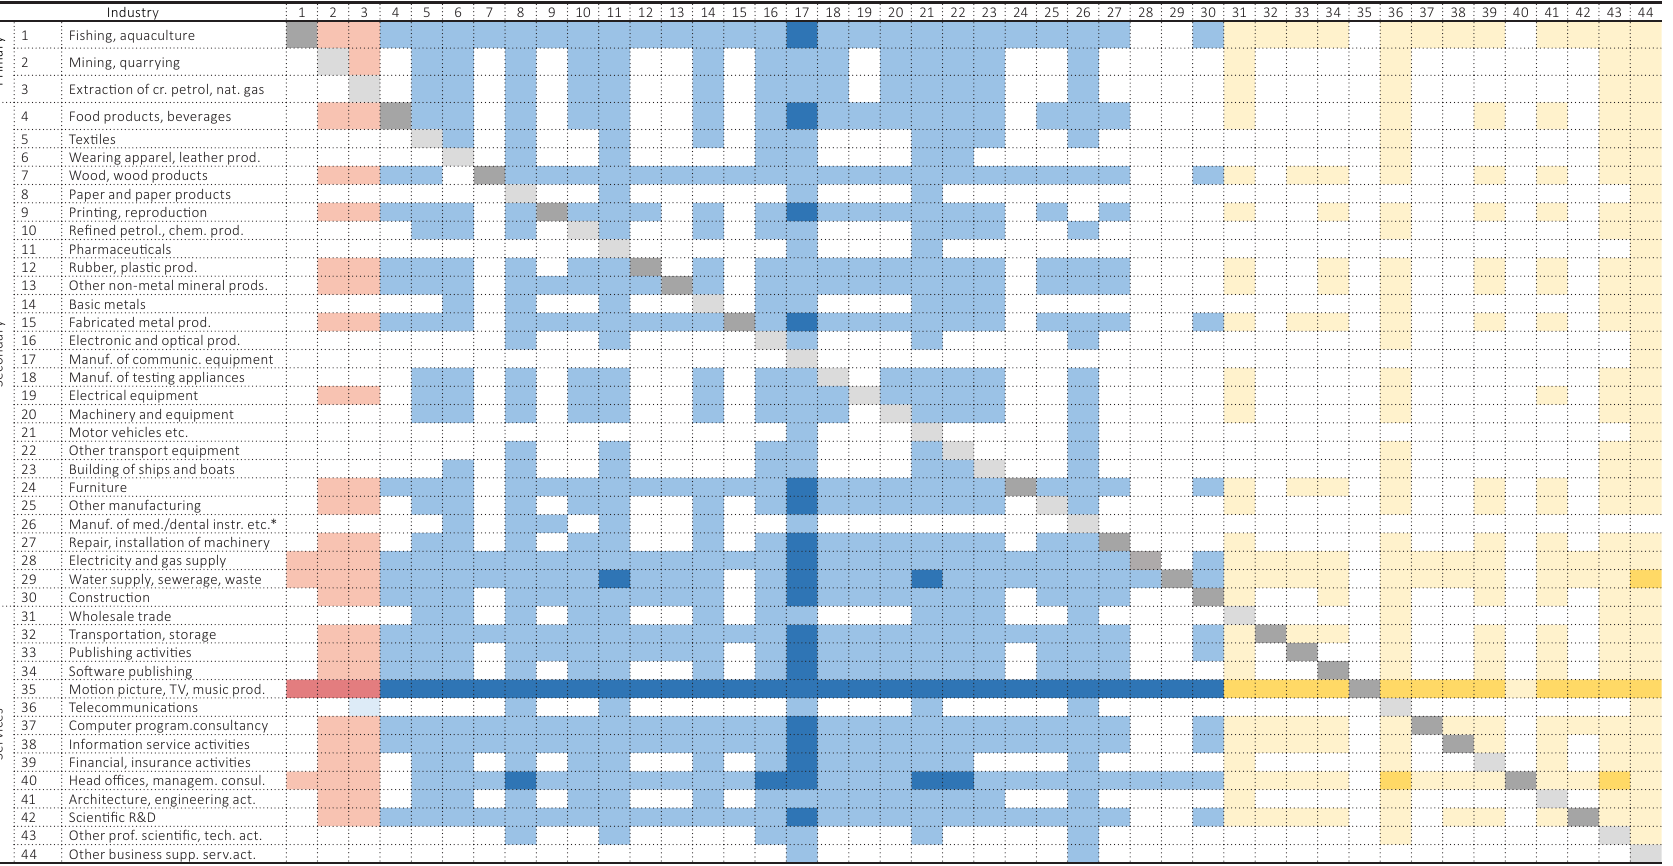
Source: Author’s elaboration.